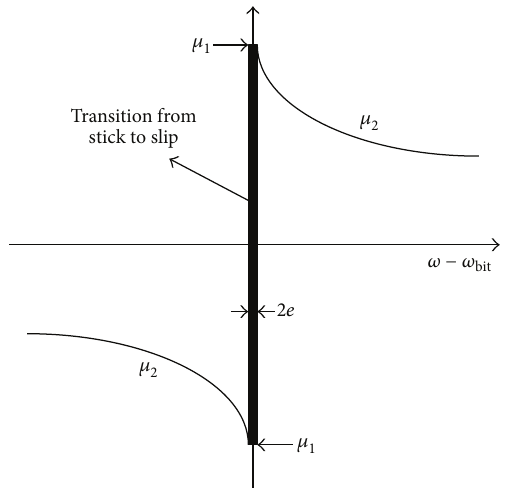
Figure 2: Torque created by the friction between the cutter and the